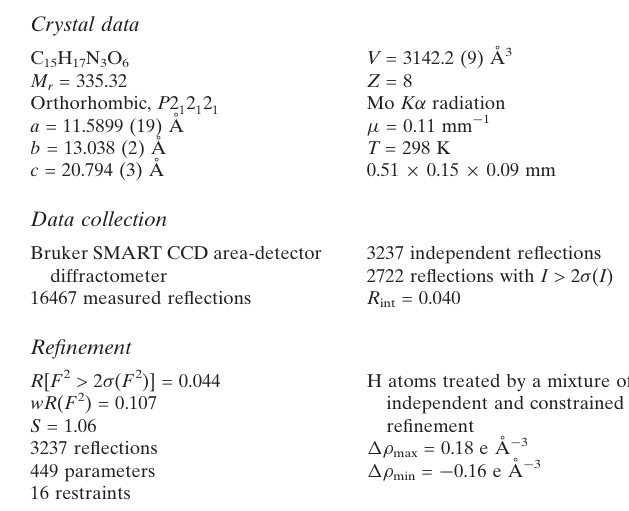
3237 independent reflections 2722 reflections with I > 2 (cid:2) ( I )